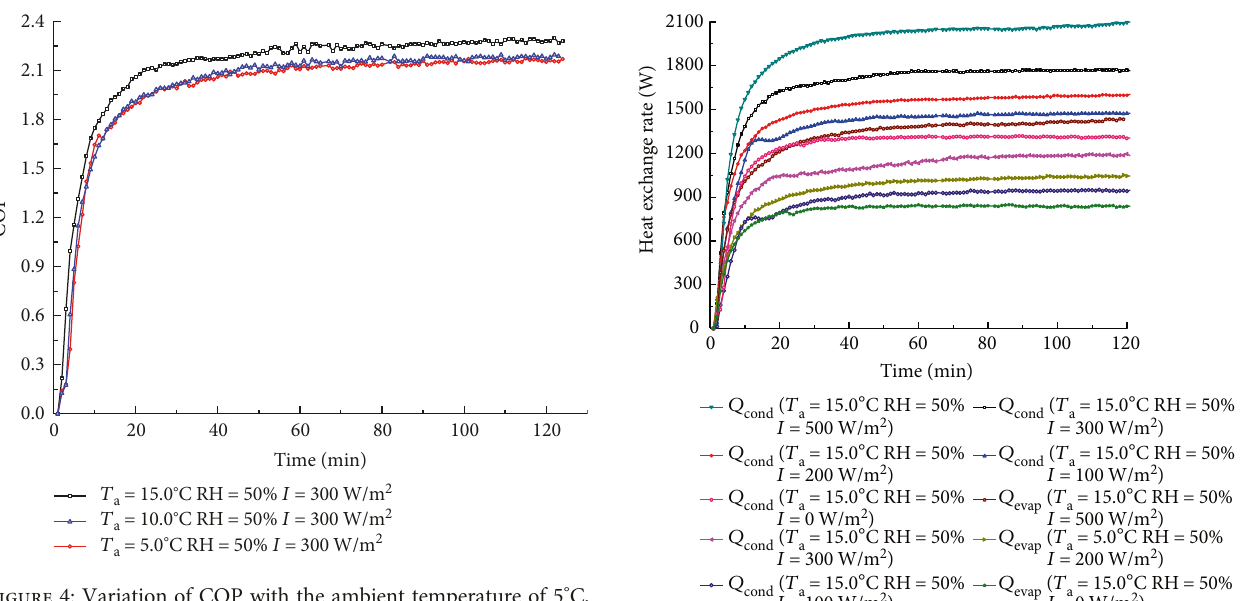
Figure 4: Variation of COP with the ambient temperature of 5 ° C, 10 ° C, and 15 ° C.